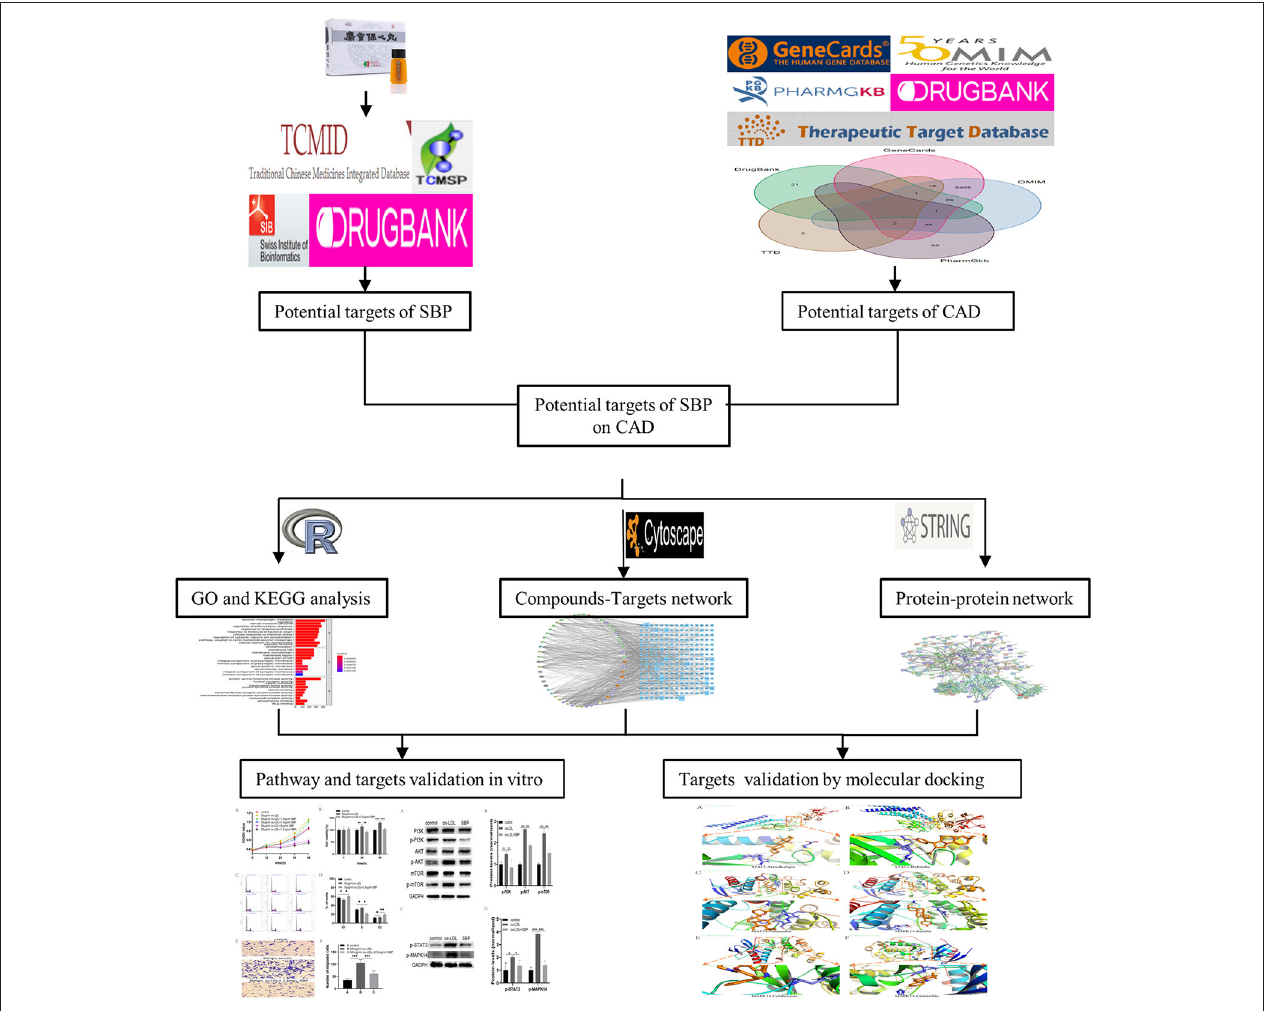
FIGURE 1 | Flowchart of the network pharmacology-based study.